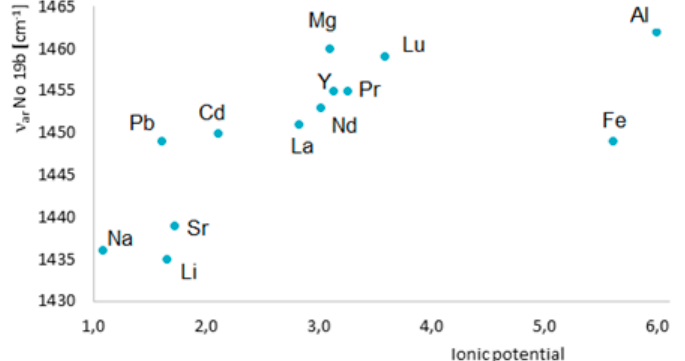
Figure 9. Dependence of the frequency of ν ar band 19b in the Raman spectra of benzoates on the metal ionic potential [36].